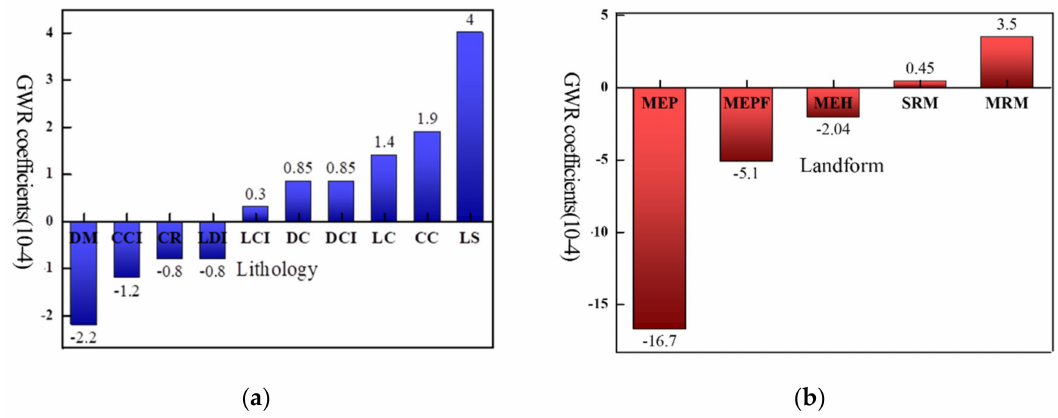
Figure 8. Statistical analysis of GWR coe ffi cients for di ff erent lithology ( a ) and landform ( b )